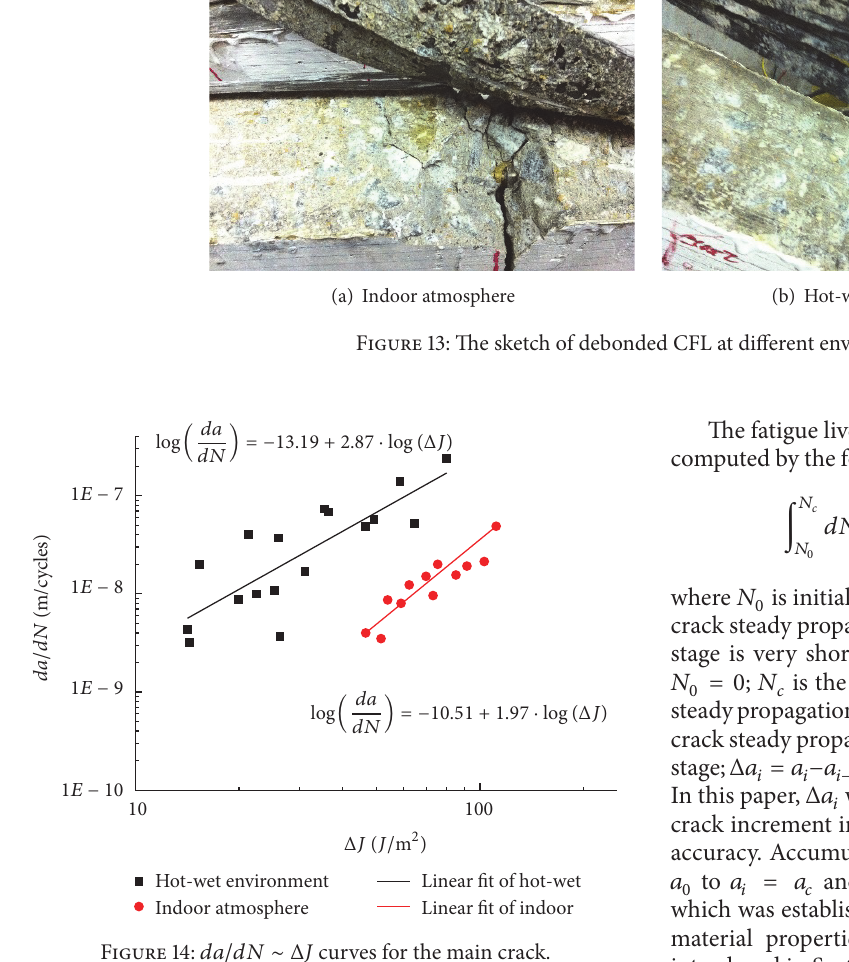
Figure 14: 𝑑𝑎/𝑑𝑁 ∼ Δ J curves for the main